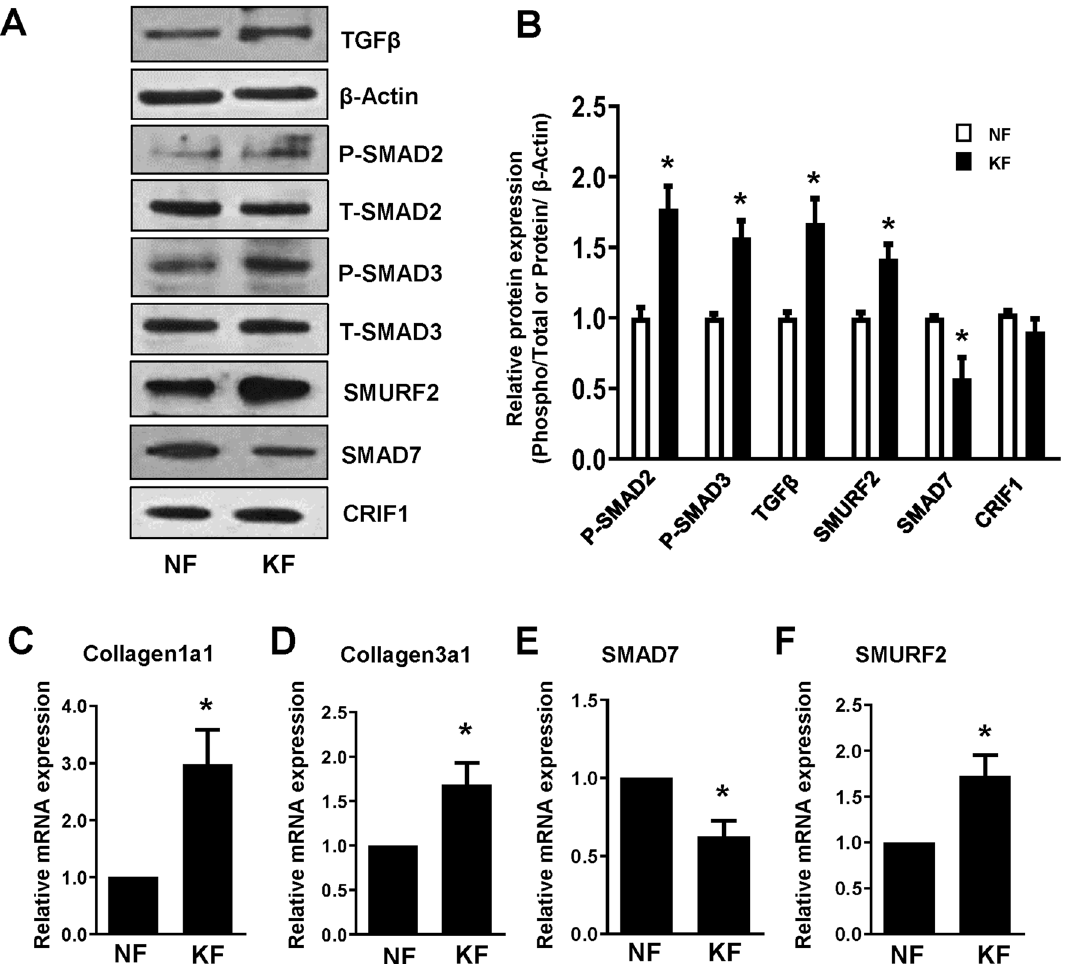
Figure 2. Comparison of transforming growth factor-β (TGF-β)/Smad expression levels between normal fibroblasts (NFs) and keloid fibroblasts (KFs). ( A ) NFs and KFs were cultured in 6-well plates for 24 h. After 24 h incubation, cells were harvested, lysed, and analyzed by western blot to assess differences in protein levels of various proteins of the TGF-β/Smad signaling pathway and CRIF1; β-actin was used as the loading control. Full- length blots are presented in Supplementary Fig. S2. ( B ) Protein density was calculated using ImageJ software. The mRNA levels of ( C ) collagen 1A1 (COL1A1), ( D ) collagen 3A1 (COL3A1) ( E ) Smad7 and ( F ) SMURF2 were determined by quantitative polymerase chain reaction (qPCR) in NFs and KFs. All data are presented as the mean ± SD of three independent experiments. * P < 0.05 relative to